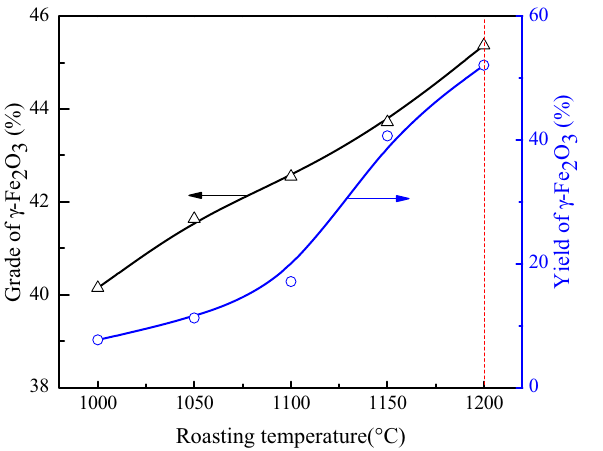
Figure 2: E ff ect of roasting temperature on γ - Fe 2 O 3 recovery.